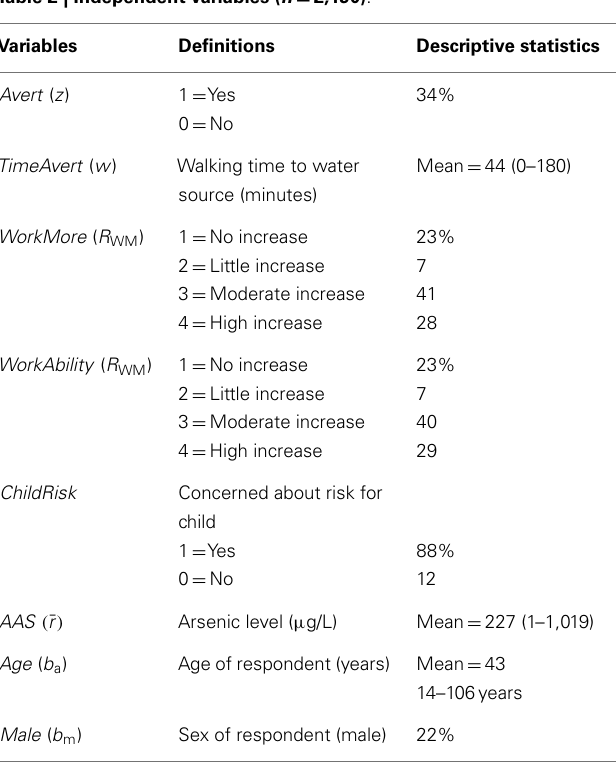
Table 2 | Independent variables ( n = 2,190)